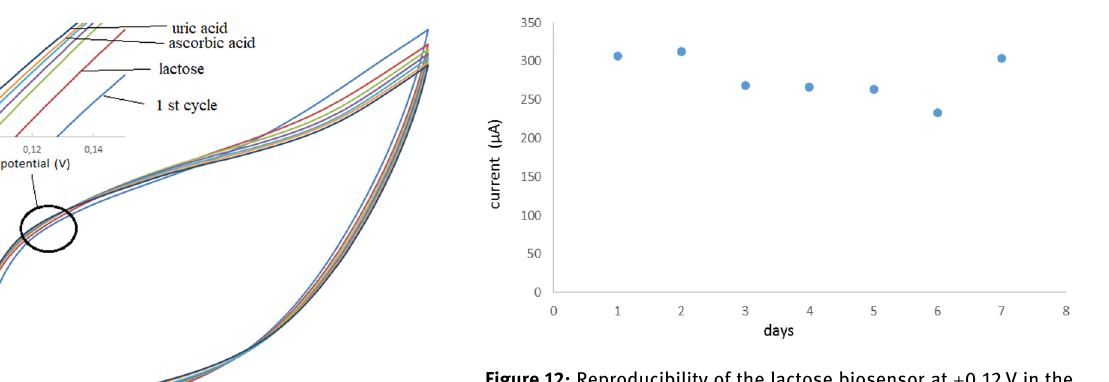
Figure 12: Reproducibility of the lactose biosensor at + 0.12 V in the range of − 0.1 to 1.0 V applied potential,